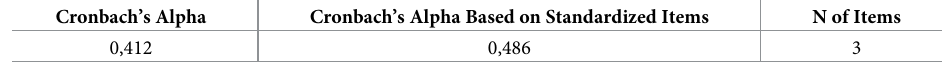
Table 9. Reliability statistics for subscale 1 (IGs).